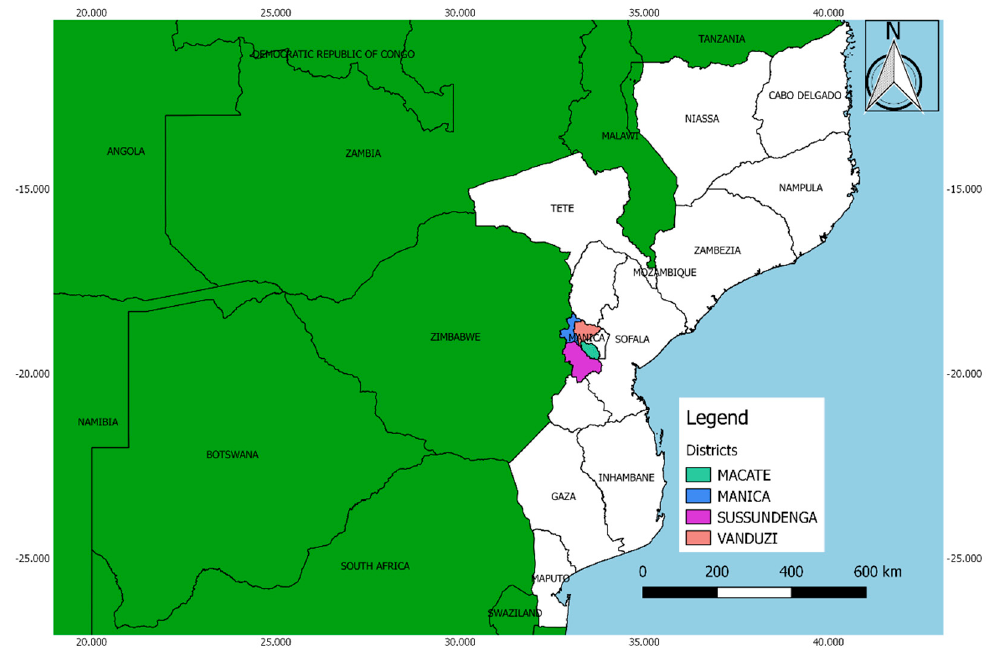
Figure 1. Sampling locations in Mozambique.